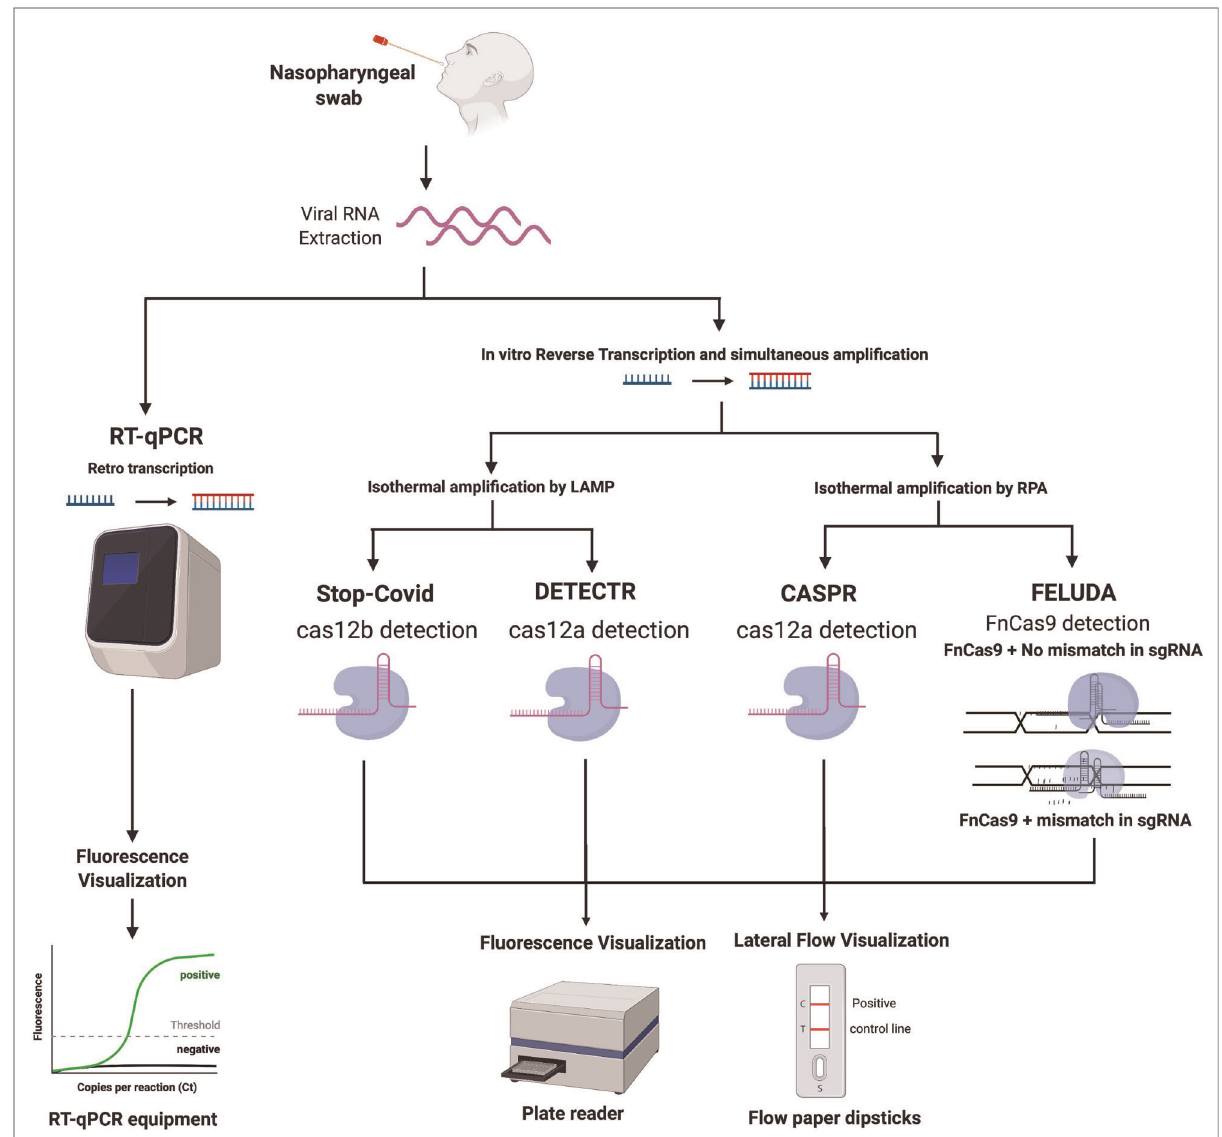
FIGURE 1 (created with BioRender.com). Work fl ow comparing different diagnostic methodologies for COVID-19. Images describe a general overview of how each method works, starting from the sample taking and then to viral RNA extraction. From this point, the next step is either direct ampli fi cation or retro transcription into DNA for further detection using different methods, potentially RT-PCR or CRISPR-based analysis, followed by the visualisation